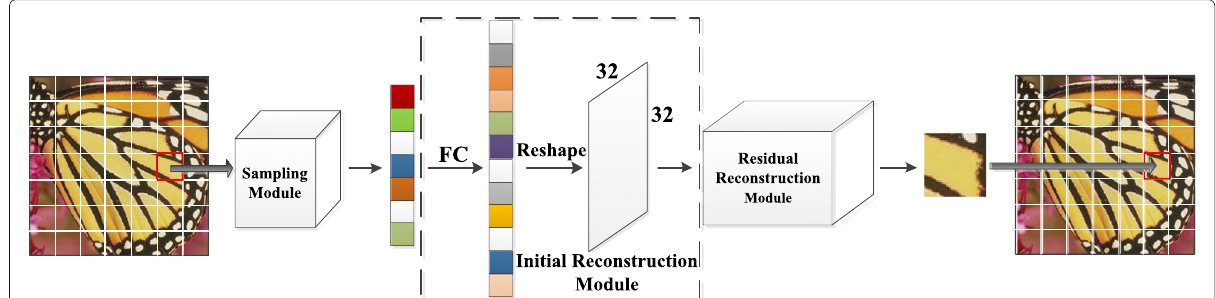
Fig. 4 The framework of